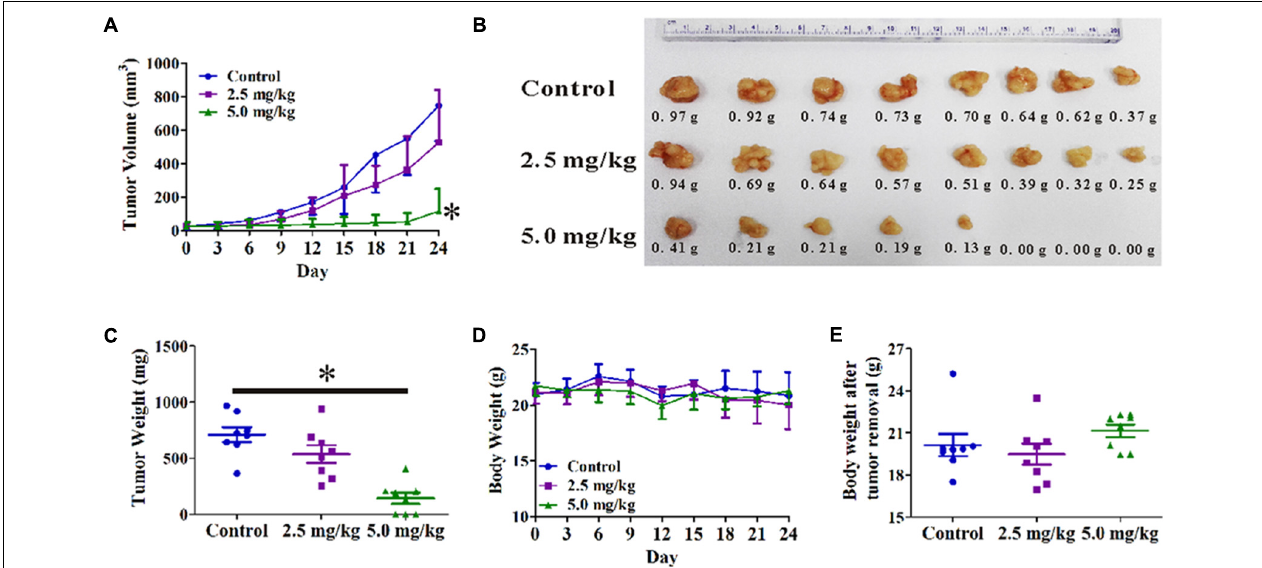
FIGURE 5 | The in vivo effects of OPD (cid:48) in nude mice bearing PC3 xenograft tumors. OPD (cid:48) was injected intraperitoneally (i.p.) at doses of 2.5 and 5.0 mg/kg/d, 5 d/wk for 24 days. Each group comprised eight mice. (A) The tumors were measured every 3 days to assess their growth. ∗ p < 0.05 vs. the control group. (B) Representative tumors were photographed after removal at the end of the experiment. (C) The weight distribution of the tumors at the end of the experiment. ∗ p < 0.05 vs. the control group. (D) Animals were monitored for changes in body weight every 3 days as an indicator of toxicity. (E) The body weights of the animals after removal of the